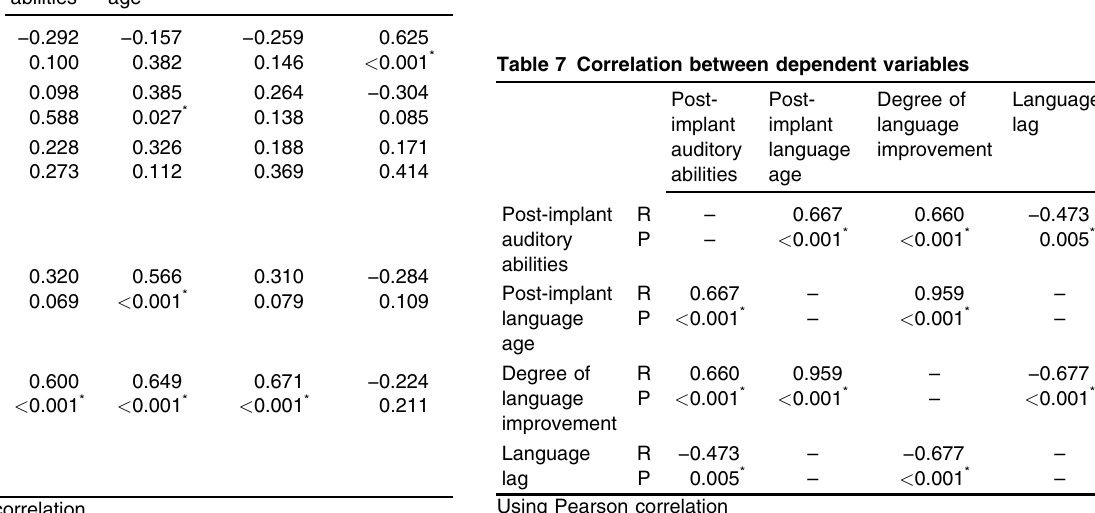
Table 6 Correlation between dependent and independent variables Independent variable